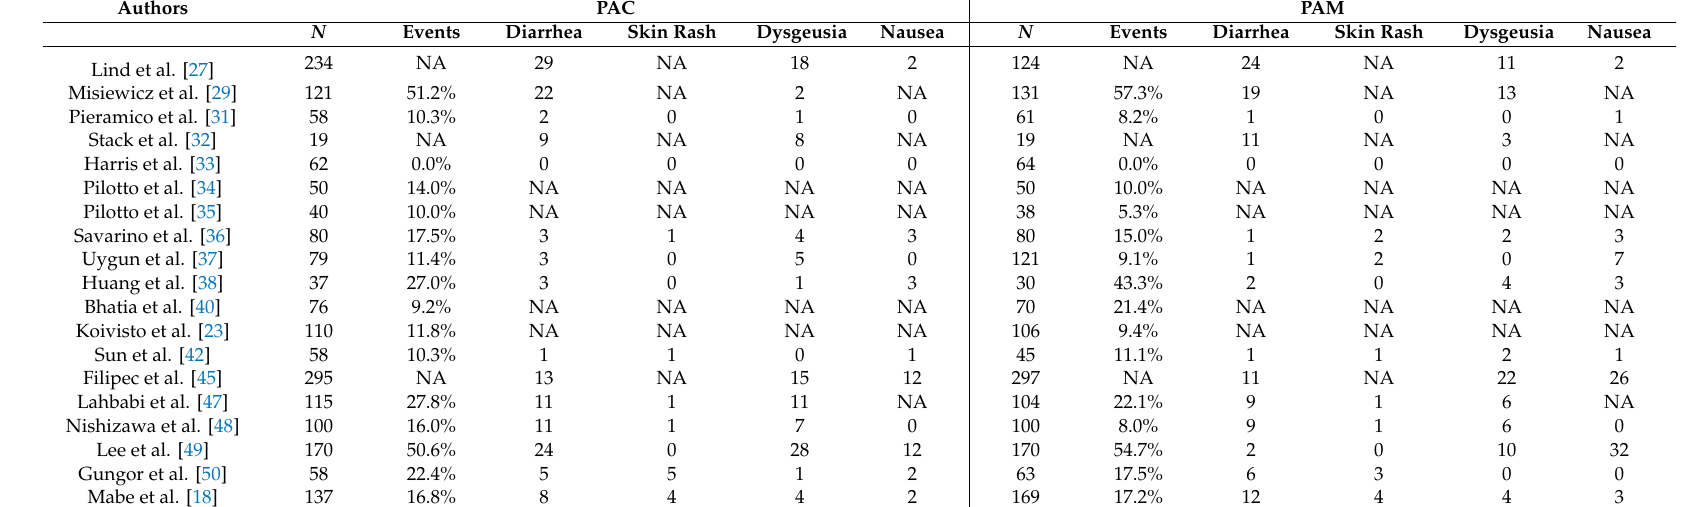
Table 2. Adverse e ff ects of PAC and PAM therapy in individual